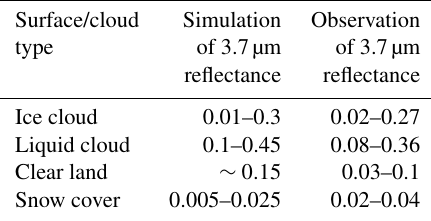
Table 2. Simulated and observed reflectance values at 3.7µm (Allen et al.,